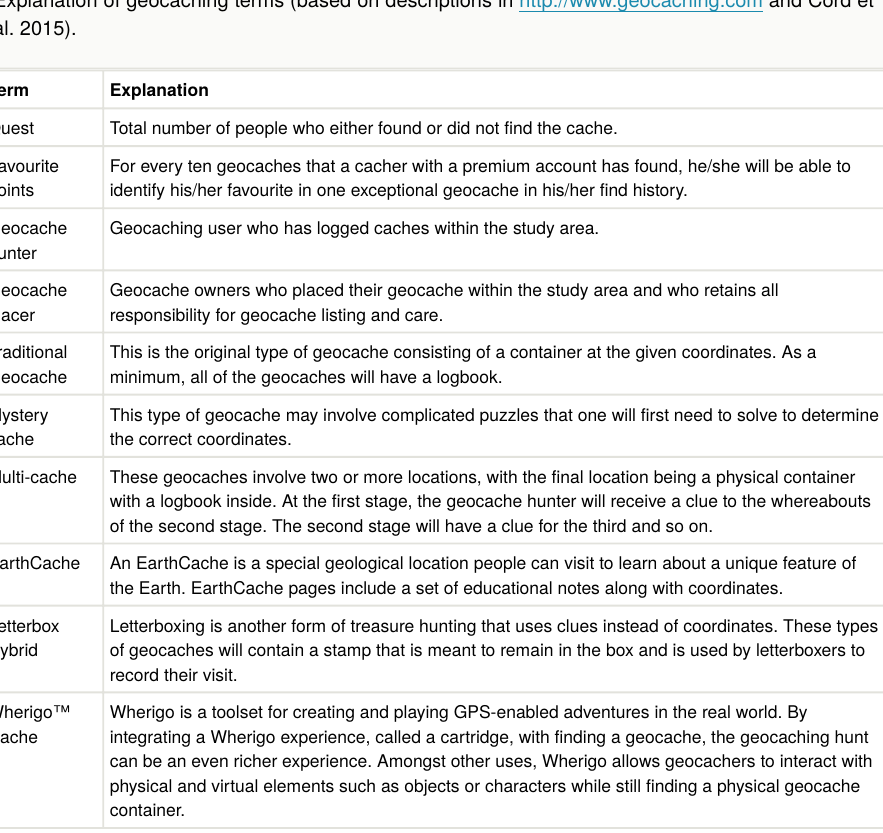
Explanation of geocaching terms (based on descriptions in http://www.geocaching.com and Cord et al.